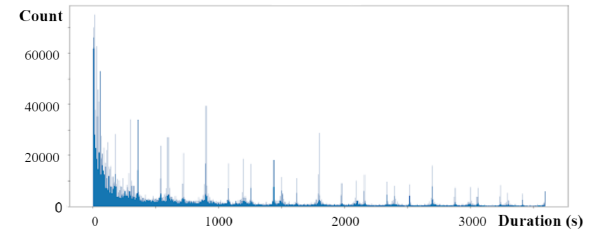
Figure 2 . Distribution of durations separating two consecutive AIS messages of a vessel. The multiple peaks can correspond to different emission tempos.